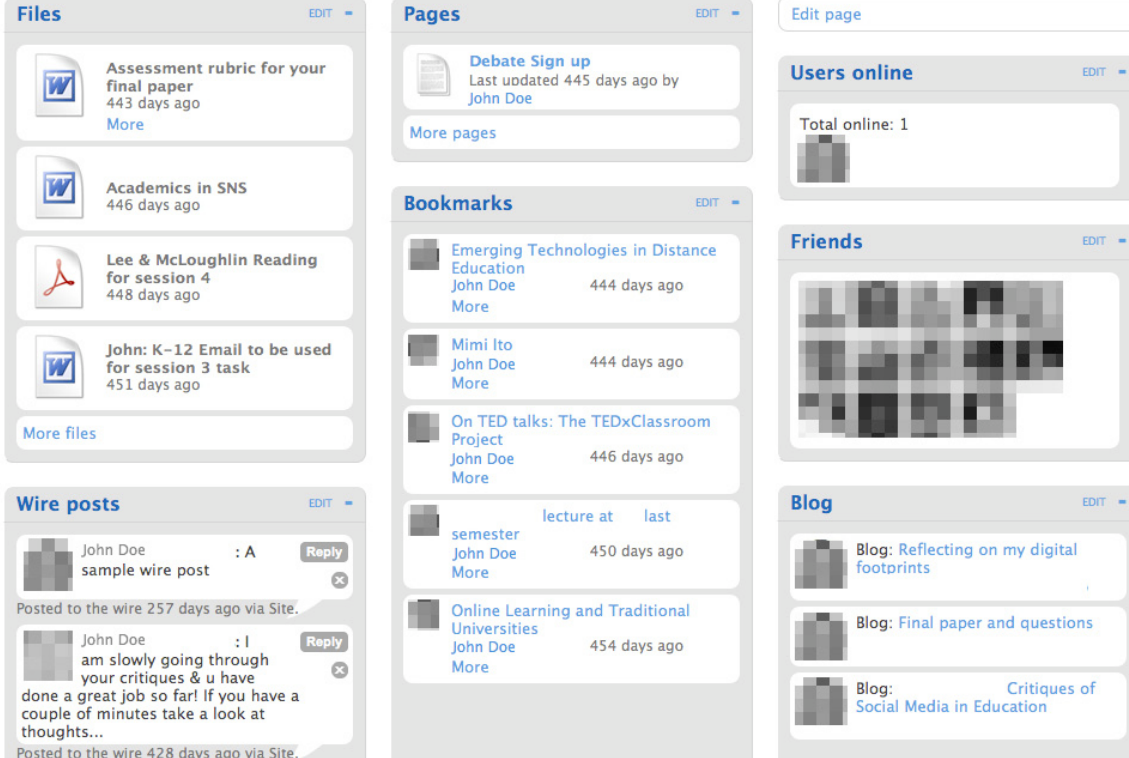
Figure 3 . The original configuration of the student dashboard.